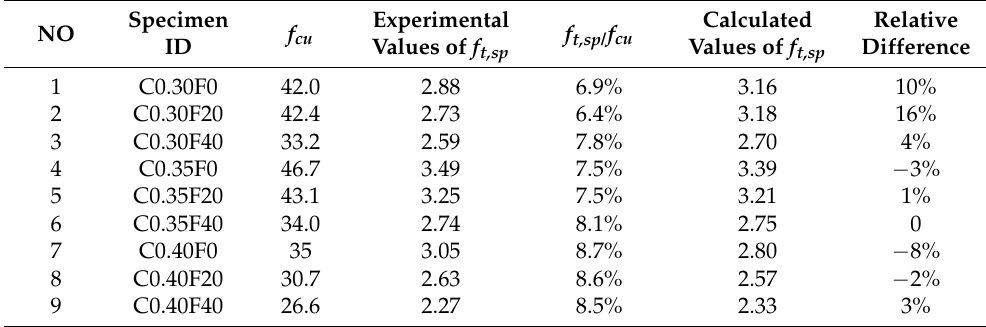
Table 9. Ratio of splitting tensile strength to compressive strength and relative